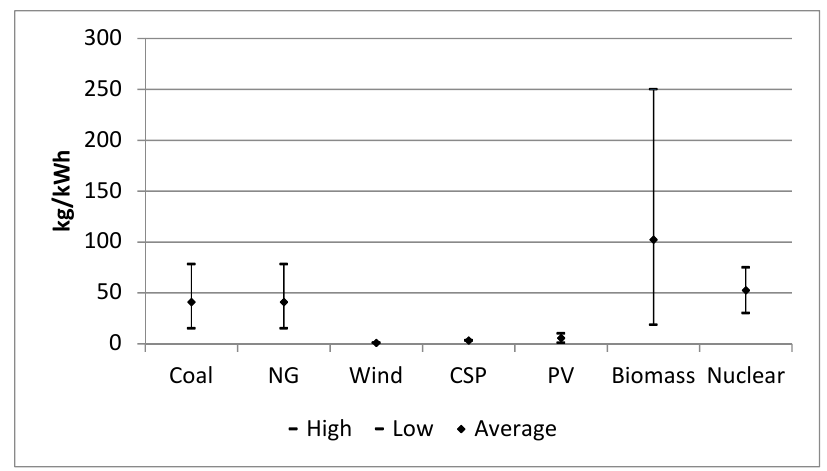
Figure 2. Water consumption by different energy systems [15,41,44,55].